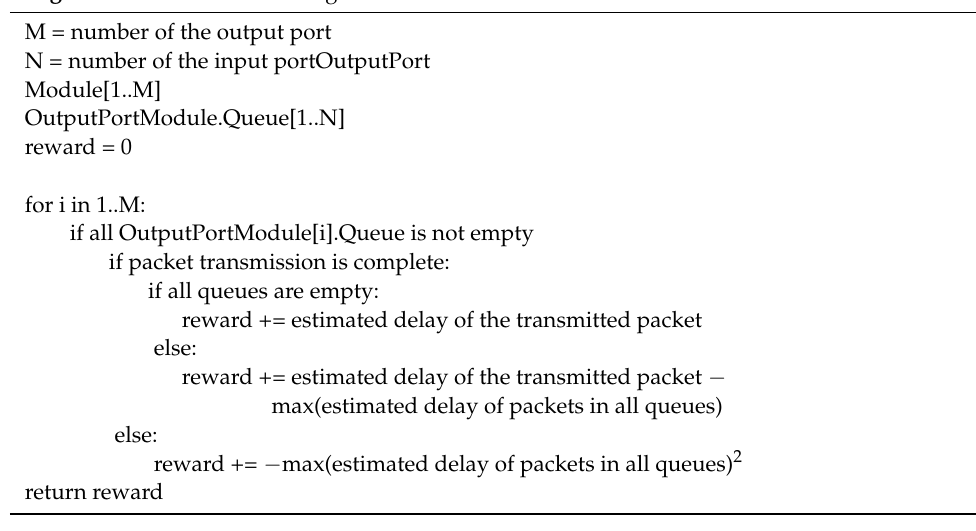
Algorithm 1. Rewards in a single